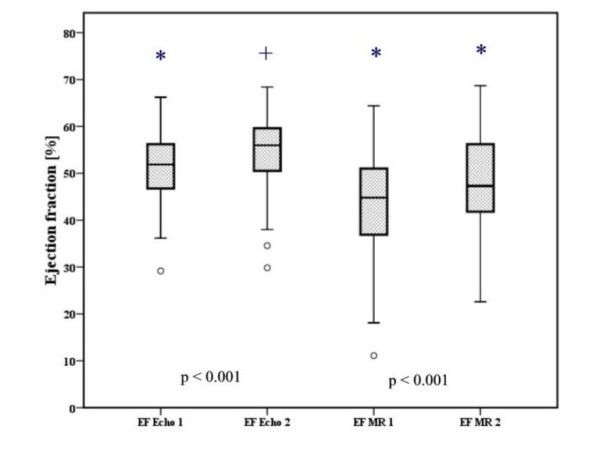
Improvement of EFecho and EFCMR at 4-month follow-up. Figure 2 shows the EF (ejection fraction) for echocardiography (51.2 ± 8.1%) and CMR (44.2 ± 11.6%, at baseline (EF echo 1, EF CMR 1) and follow-up (EF echo 2, EF CMR 2) (54.5 ± 8.3%, and 49.2 ± 11%, respectively) and visualises the statistically highly significant (p < 0.001) improvement at 4-month follow-up. (* p < 0.001, + p < 0.01). Data is presented as mean ± standard error and median.